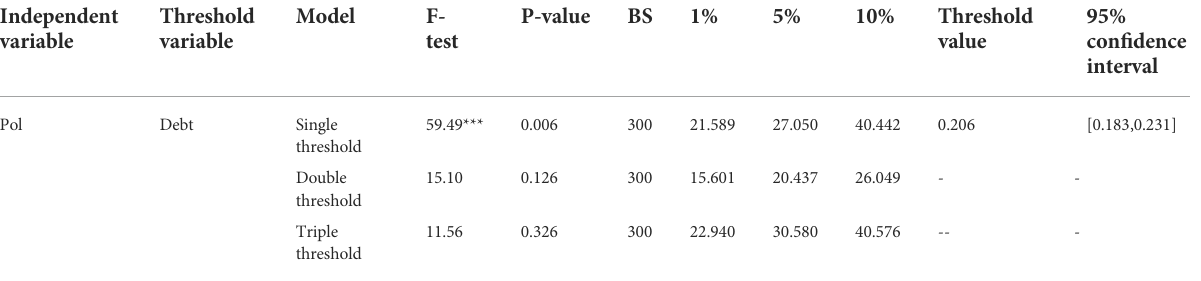
TABLE 7 Test results of threshold effect and the value of threshold